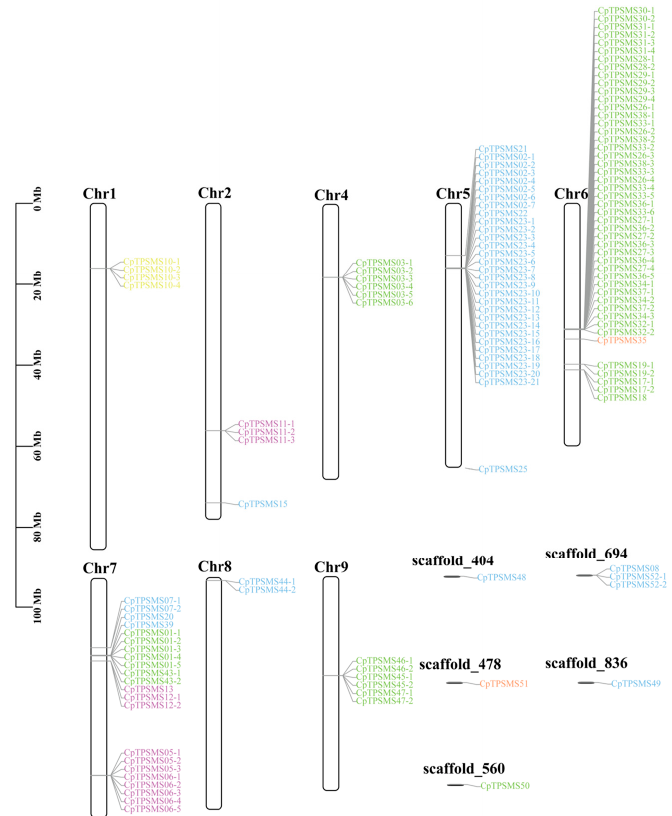
Figure 4. Chromosomal location of CpTPSMSs. Names of makers are shown on the right side of the chromosome. Blue, green, yellow, purple and orange indicate that CpTPSMSs were from the TPS-a, TPS-b, TPS-c, TPS-e/fand TPS-g subfamilies, respectively.